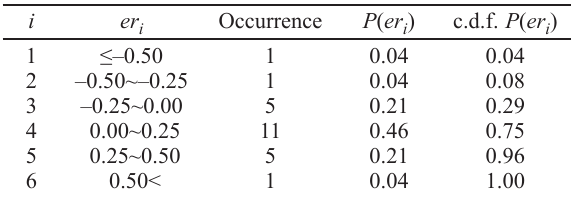
Table 2. Probability of er i , P ( er i ), for the entire event space e